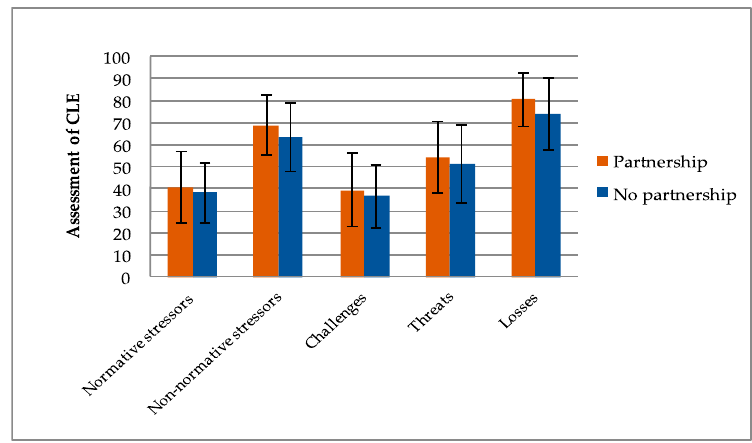
Figure 1. Mean differences between participants with partnership and participants without partnership regarding the assessment of normative stressors, non-normative stressors, challenges, threats and losses. Error bars represent standard deviation.